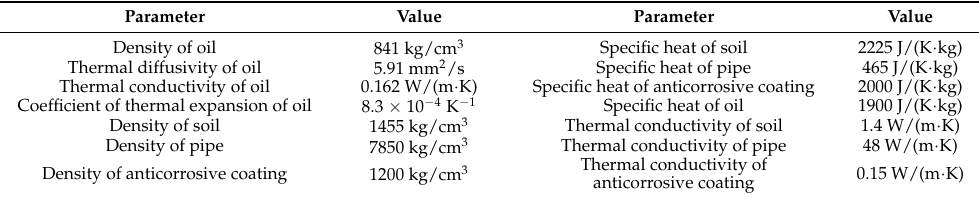
Table 1. Physical parameters of oil, soil, anticorrosion coating and pipe.